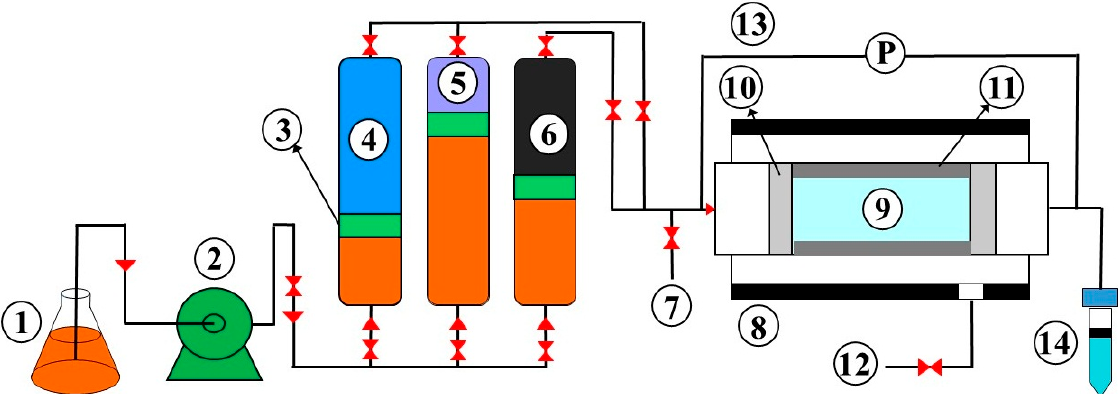
Figure 1. Schematic diagram of core flooding tester: (1) hydraulic oil, (2) pump, (3) piston plate, (4) water or brine accumulator, (5) polymer accumulator, (6) oil accumulator, (7) bypass valve, (8) core holder, (9) core plug, (10) distributor, (11) sleeve, (12) confining pressure, (13) pressure gauge, (14)